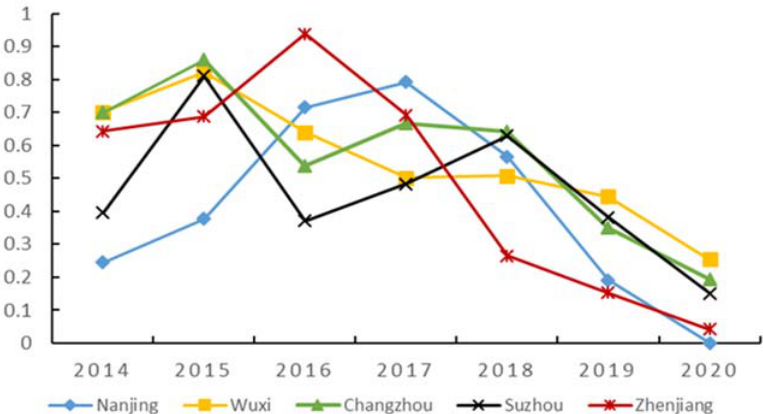
Figure 5. The order degrees of resource input subsystems of Taihu Basin among cities during 2014–2020.